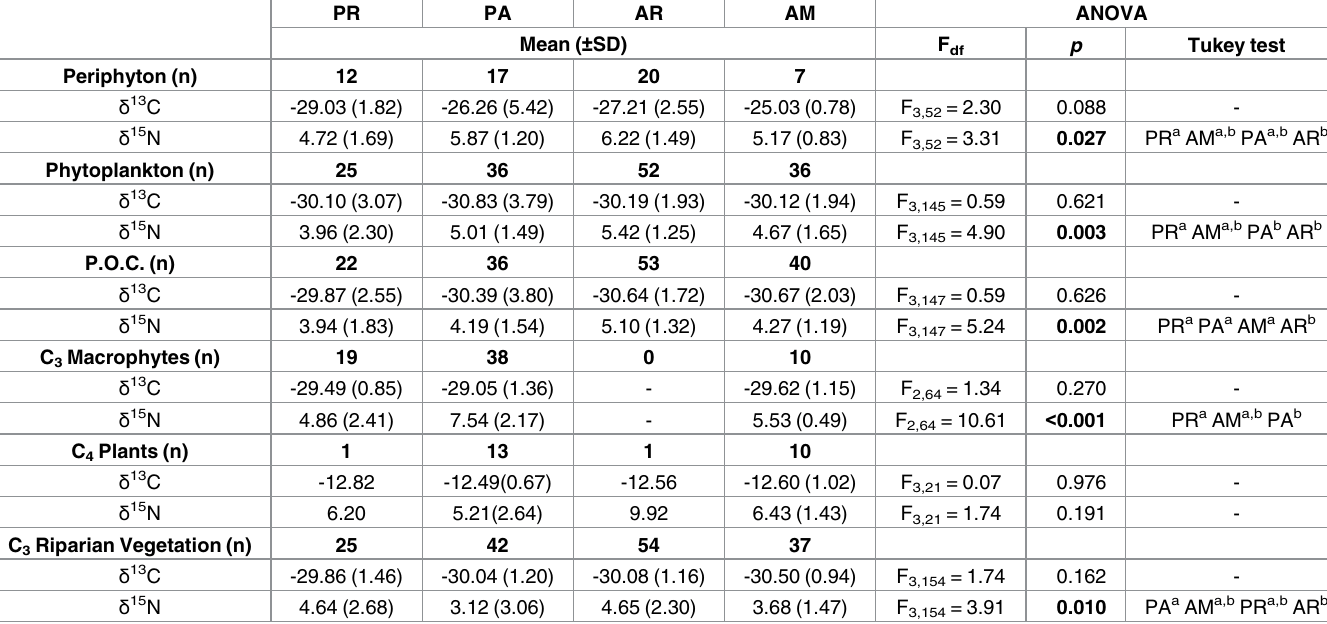
Table 2. Mean (‰) and standard deviation ( ± SD)of carbon and nitrogen isotope values for each carbon source, and ANOVA results for the test of differences among basins. PR = Parana´; PA = Pantanal; AR = Araguaia;AM = Amazon; n = numberof samples for each source in each basin. Shared superscript lowercaseletters indicate lack of significantdifferences for the Tukey post-hoc test.